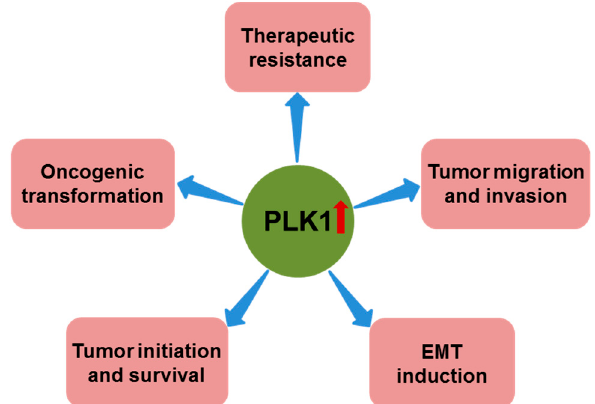
Figure 2. Role of polo-like kinase 1 (PLK1) overexpression in cancer. In addition to its role in promoting cancer cell proliferation and suppressing apoptosis, PLK1 overexpression has also been reported to have important roles in oncogenic transformation, tumor initiation and survival, epithelial-mesenchymal transition (EMT) induction, tumor migration and invasion, and therapeutic resistance.